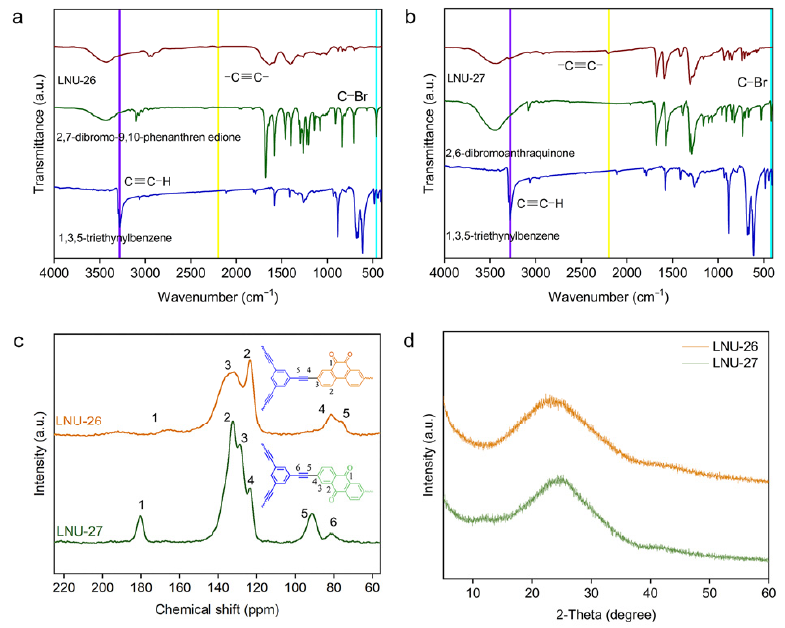
Figure 1. FTIR spectra for ( a ) LNU-26 and ( b ) LNU-27, ( c ) solid-state 13 C NMR spectra for PAF solids, and ( d ) PXRD patterns for PAF solids.